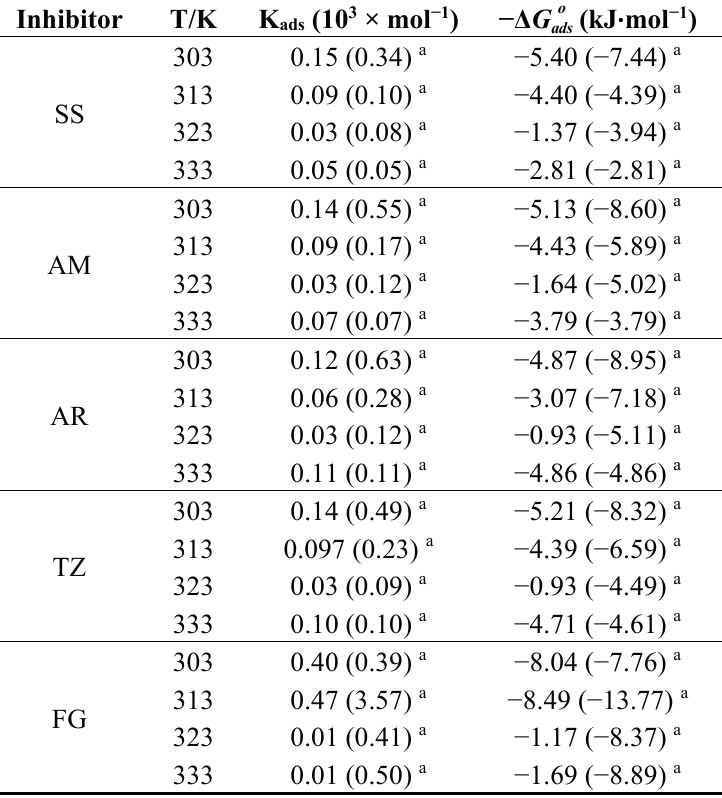
Table 2. Thermodynamic parameters for adsorption of the studied dyes on mild steel surface at different